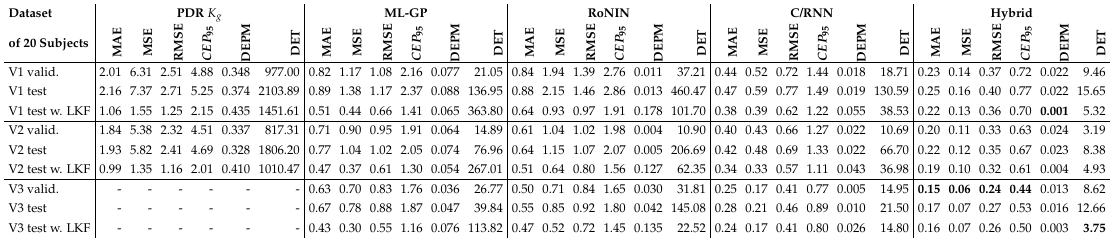
Table 2. Accuracy; datasets V1–V3; velocity errors in m/s, distance errors in m. Dataset PDR K